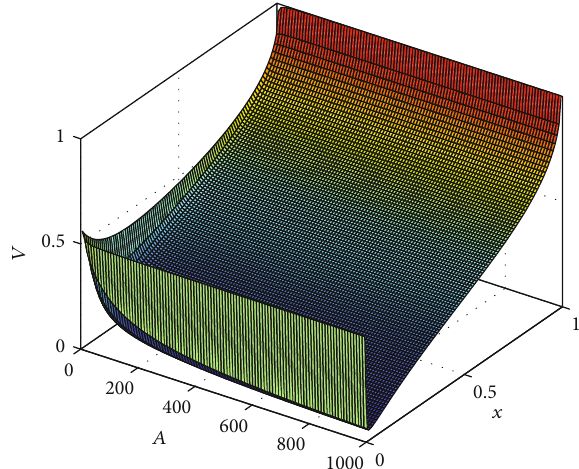
Figure 8: The smallesteigenvalue V of the two-modecavity radiation versus the linear gain coe ffi cient A and initial preparation of atoms x for κ = 0 : 5 and ε = 0 : 06 .